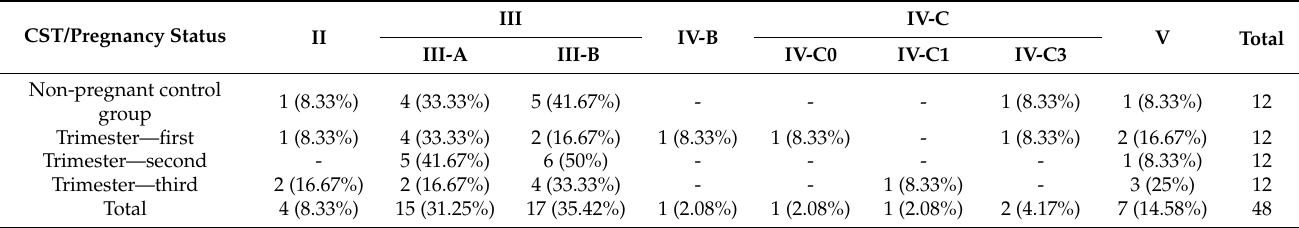
Figure 2. Community State Assignment (CST) of vaginal microbiomes across the three trimesters of pregnancy in comparison to non-pregnant state using VALENCIA. ( A ) Similarity of vaginal samples to the assigned CST and subCST designations. ( B ) CST classification of the vaginal samples, as revealed by VALENCIA. Table 1. Distribution of samples in each community state-type according to pregnancy